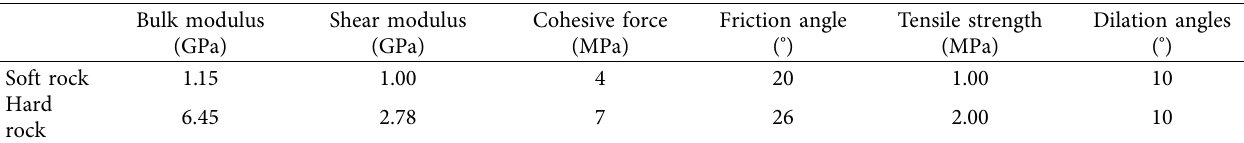
Table 2: Rock mass parameters of composite